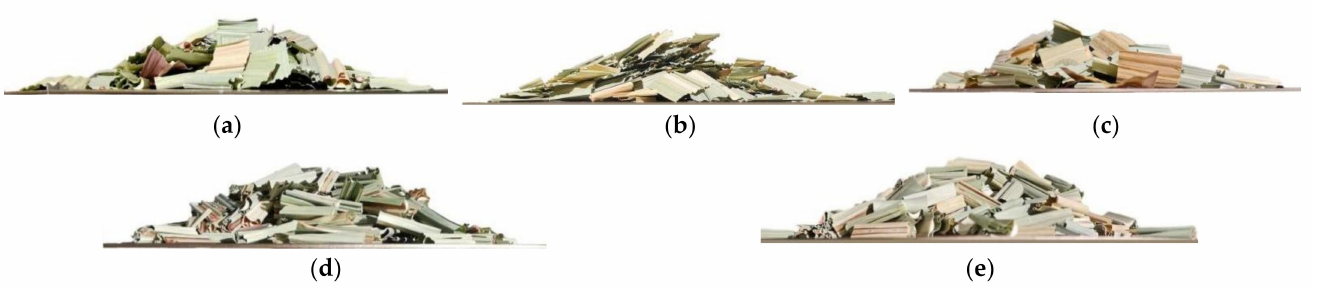
Figure 8. Physical stack of sugarcane leaves with different shapes: ( a ) mixed leaves based on the actual measurement proportion, ( b ) flat leaves, ( c ) slightly deformed leaves, ( d ) moderately deformed leaves, ( e ) seriously deformed